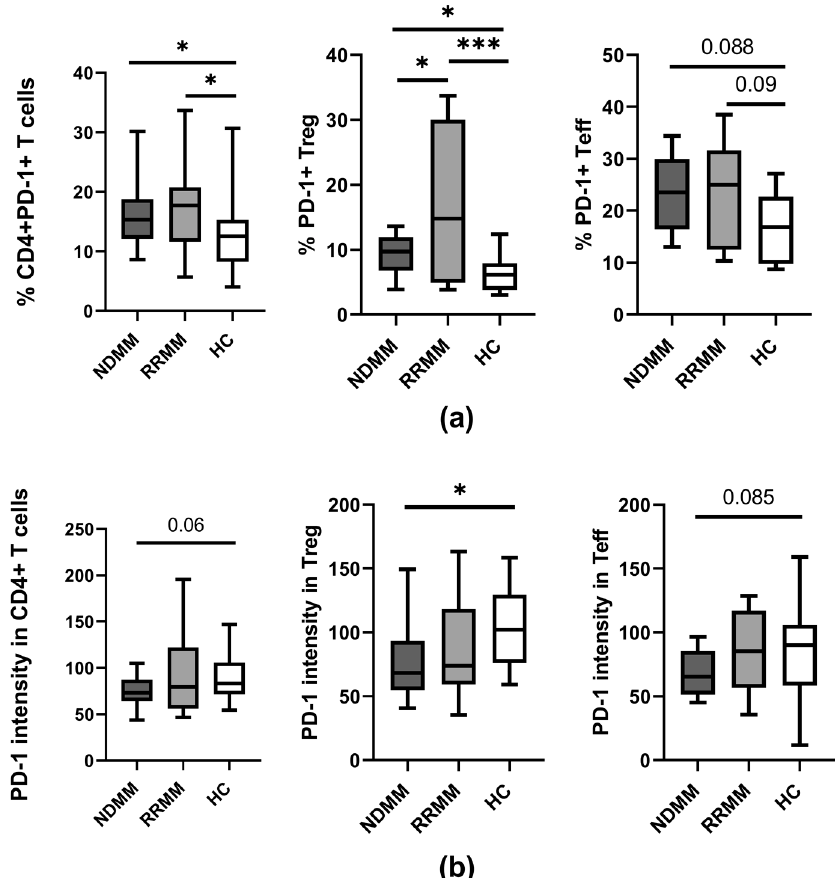
Figure 1. PD-1 expression on PB CD4 T cell subtypes of MM patients in the different clinical stages and healthy controls. ( a ) Frequency of PD-1-expressing CD4 + T cells (identified as CD3 + CD4 + ), Treg (identified as CD4 + CD127 − ), and Teff (identified as CD4 + CD127 + ) cells in healthy controls (HC) (n = 20) and patient subgroups (NDMM and RRMM) (n = 26 and n = 14, respectively). ( b ) PD-1 level (determined as mean fluorescence intensity) in CD4 + T cells, Treg, and Teff cells in HC (n = 20), NDMM (n = 26), and RRMM (n = 14) patients. Boxes and whiskers show 25th and 75th interquartile range and minimum–maximum, respectively; the median is the central line in each box. The differences between the studied groups were statistically evaluated using Kruskal–Wallis, ANOVA, and Mann–Whitney U tests. * p < 0.05, *** p < 0.001.